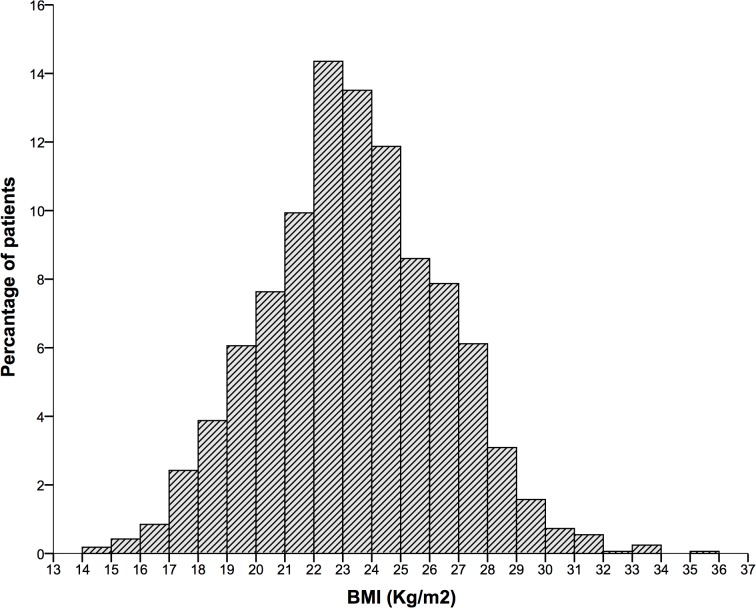
Distribution of BMI in the study population.